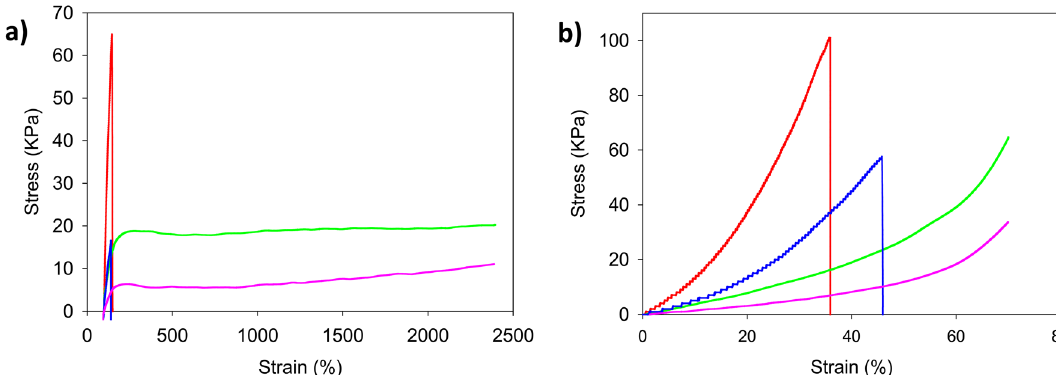
Figure 5. ( a ) Stress–strain curves of PAAm-MSiO 2 and PAAm-BIS hydrogels prepared by varying the BIS and MSiO 2 under uniaxial tension and ( b ) stress–strain curves of PAAm-MSiO 2 and PAAm-BIS hydrogels prepared by varying the concentration of BIS and MSiO 2 under uniaxial compression. In the graph, red line, green line, blue line, and purple line represent PAAm (4 M)-BIS 1.00%, PAAm (4 M)-MSiO 2 1.00%, PAAm (2 M)-BIS 1.00%, and PAAm (3 M)-MSiO 2 0.75% hydrogels, respectively. Elongation at break (%) Tension Compression Tension Compression Tension Hydrogel code